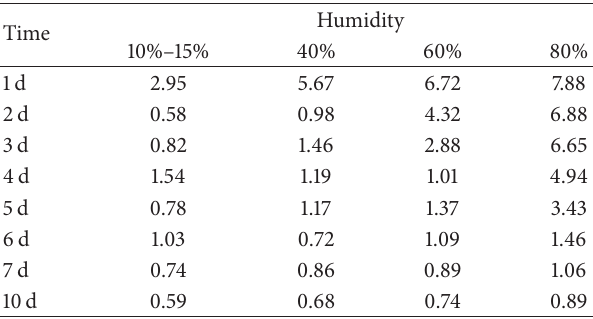
Table 6: Variation relationship of curing humidity, time, and water content (the water content is in mass